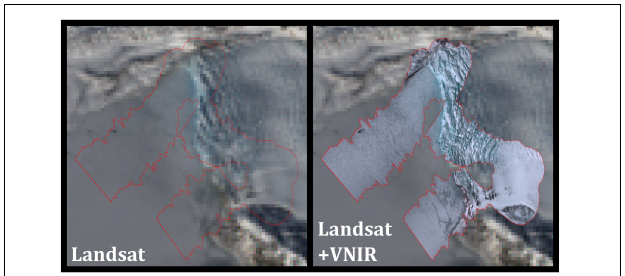
FIGURE 7 | Satellite (Landsat) imagery of the Conwaybreen glacier in Svalbard, acquired on April 27th, 2015. A pushbroom image created from the VNIR imager’s RGB channels is overlaid on the right panel and is outlined in red on both. The satellite image has been slightly darkened to emphasize the VNIR